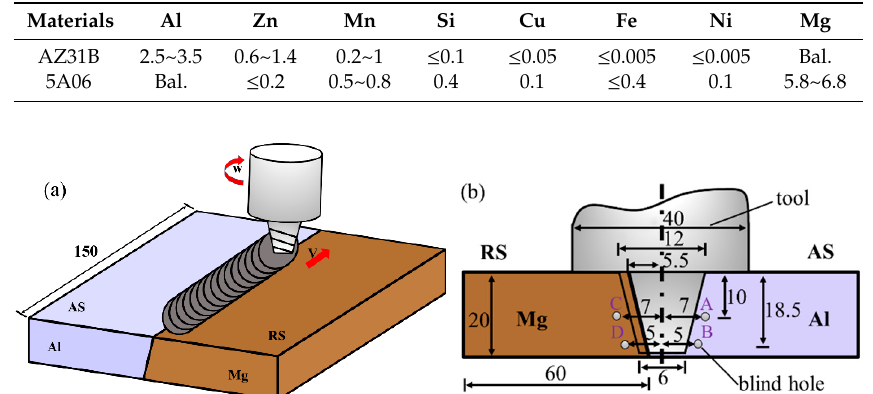
Figure 2. ( a ) Schematic of butt configuration in dissimilar friction stir welding (FSW) Al / Mg alloys ( b ) Temperature measurement (unit: mm).